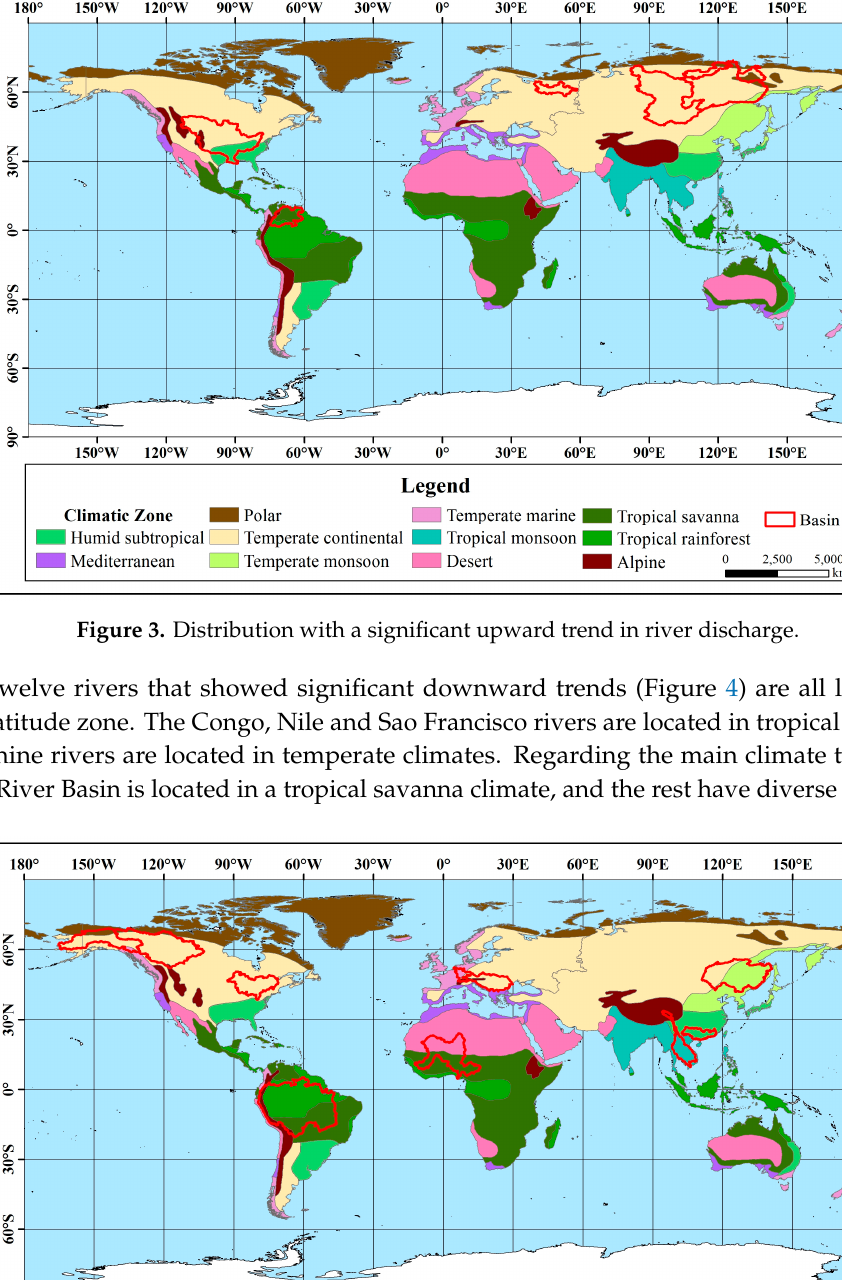
Figure 4. Distribution with a significant downward trend in river discharge.